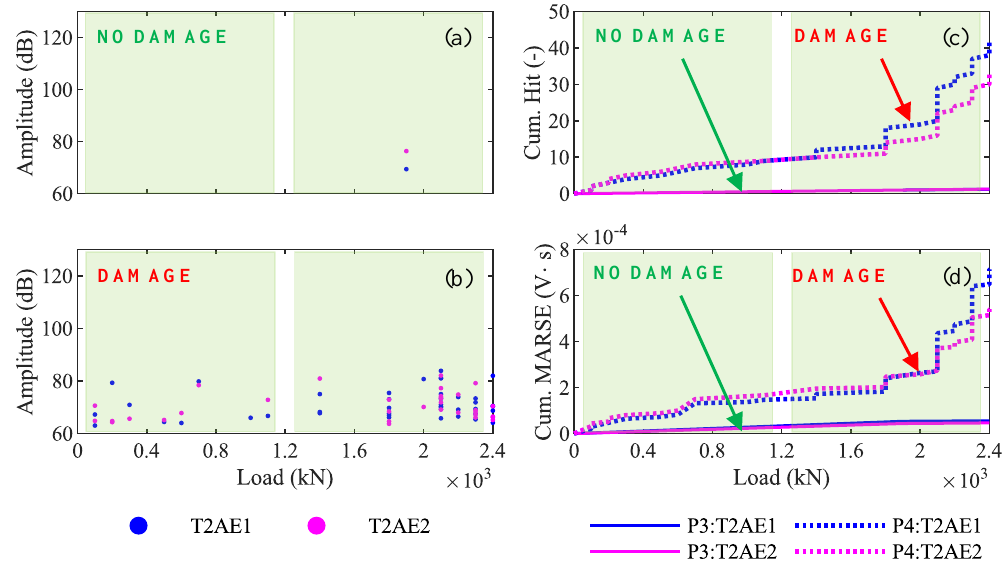
Figure 19. Differences in amplitude ( a , b ) and cumulative signal strength ( c , d ) between the AE acquired from the viaduct without pre-existent cracks (phase P3) and with pre-existent cracks (phase P4) for loads between 0 kN and 2400 kN.